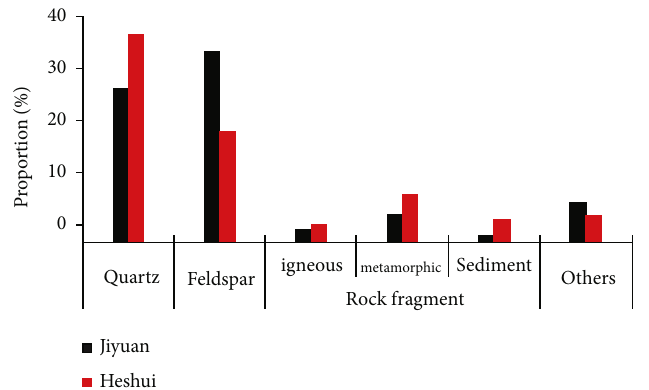
Figure 3: Fragment compositions in the research areas.